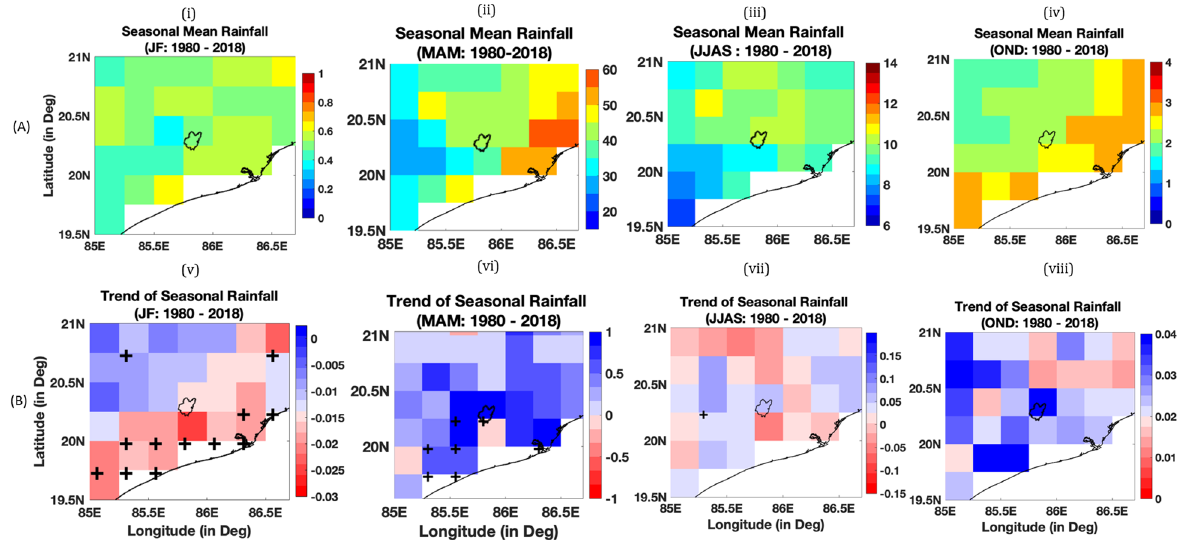
Fig. 6 Spatial distribution of A seasonal mean rainfall (black colour figure represents Bhubaneswar city boundary) for (i) Jan – Feb, (ii) Mar-Apr-May, (iii) Jun-Jul-Aug-Sept, and (iv) Oct-Nov-Dec; B is same as A but for trend of seasonal rainfall (black colour figure represents Bhubaneswar city boundary and black “ ” shows the grid points having stastically significant +